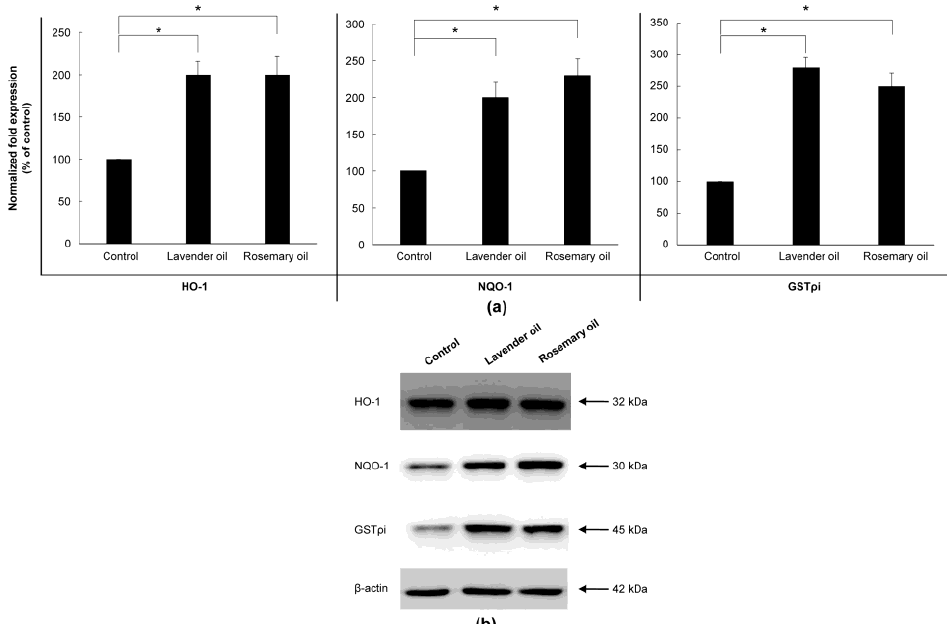
Figure 8. Upregulation of phase II enzymes by lavender (0.01%) and rosemary (0.01%) oils in the 3D- Dermal papilla cell (3D-DPC) culture system. To confirm the results of the 2D-DPCs culture system, cells were treated with essential oils in the 3D-DPCs culture system. ( a ) Phase II enzyme mRNA expression was analyzed by qRT-PCR. * p < 0.01 between the essential oils-treated samples and non- treated control DPCs. ( b ) Phase II enzyme protein expression was analyzed by Western